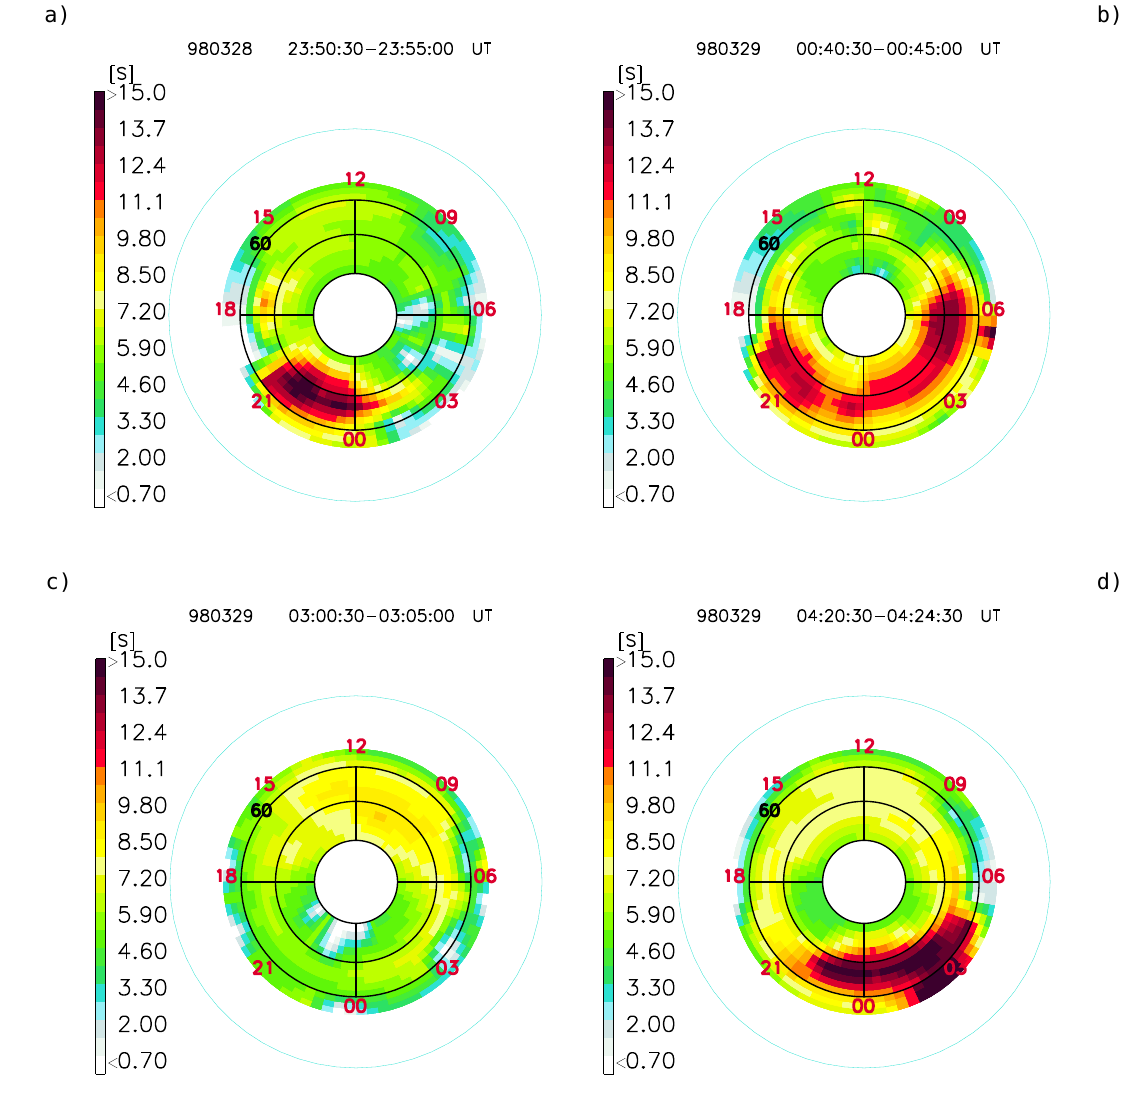
Fig. 5. Pedersen conductance maps derived from measurements by the UV and X-ray imagers on board the Polar satellite for the time periods of (a) 23:50–23:55 UT, (b) 00:40–00:45 UT, (c) 03:00–03:05 UT, and (d) 04:20–04:25